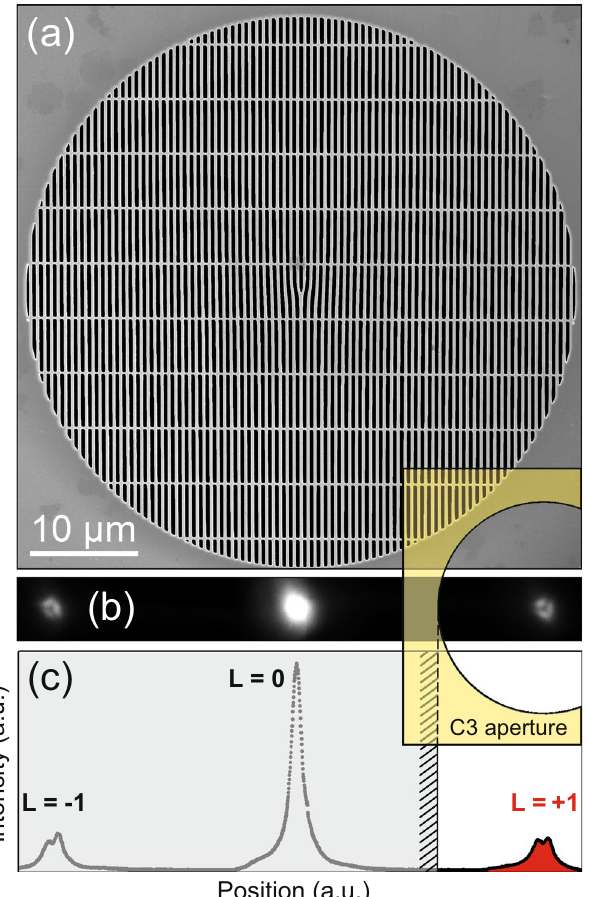
Figure 1. Generation of electron vortex beams with user-selected OAM using a fork-type aperture. ( a ) Scanning electron microscope image of a 50 µ m dislocation aperture (places at the C2 aperture level). The horizontal ligaments are used as reinforcement of the 200 nm thick Pt foil. ( b ) Image of the electron probe at the sample. The position of the selected probe (L = + 1) with respect to the discriminator aperture at the C3 aperture level is illustrated by the overlaid yellow structure. ( c) Intensity profile across the probe (in arbitrary units). The signature donut shape of the outer vortices with |L| = 1 is reflected by a dip in the intensity distribution of these (partial)